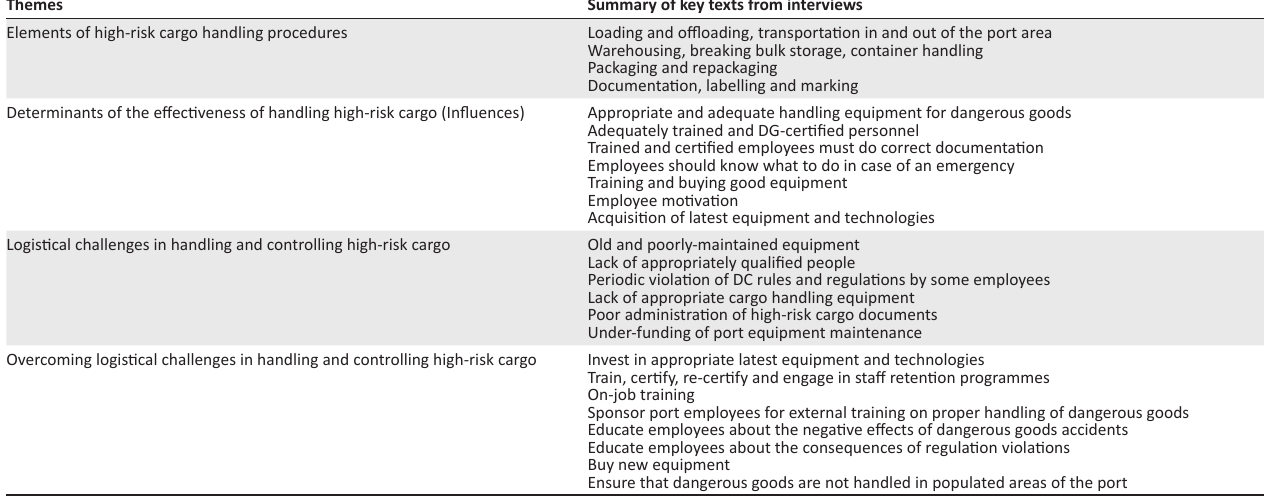
TABLE 6: Summary of key text extracts from the study’s interview transcripts.